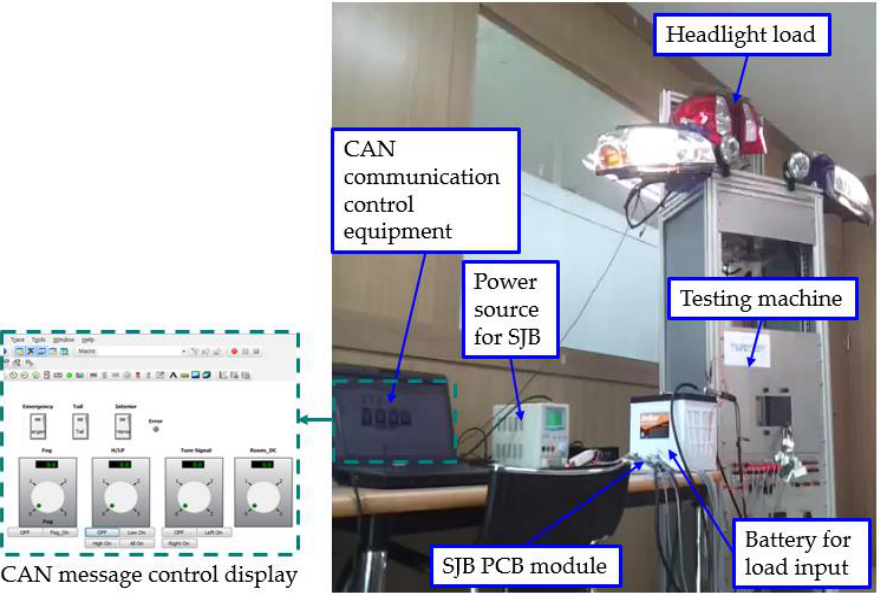
Figure 12. Test environment.